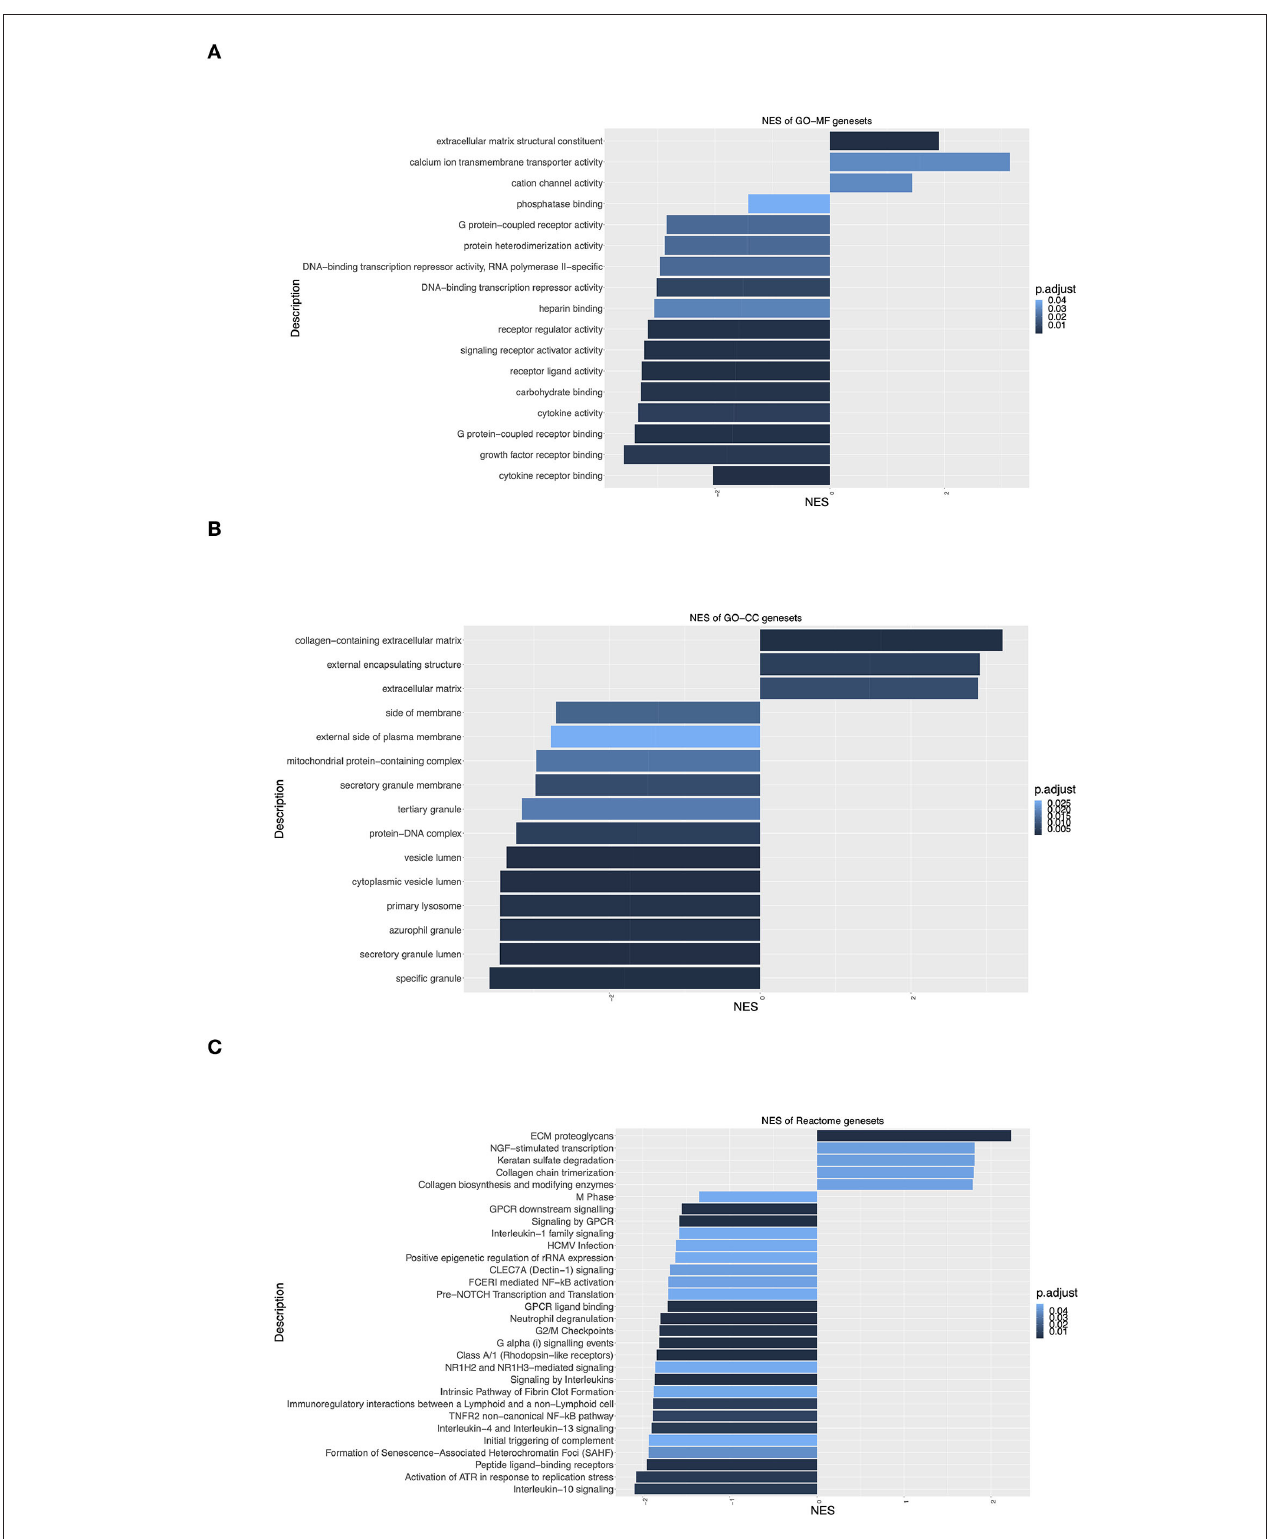
FIGURE 5 | Gene Ontology (GO) enrichment analysis of differentially expressed genes. (A) Molecular Function (GO-MF) enrichment. (B) Cellular Component (GO-CC) enrichment. (C) Reactome signaling pathway enrichment. Y-axis label represents different GO terms, and X-axis label represents normalized enrichment scores (NES) (IHD n = 8, Ctrl n = 7). Positive/negative enrichment scores indicate a shift of genes toward upregulation/downregulation of the ranked list. Adjusted p -value (BH) or p.adjust < 0.05 means significant change.